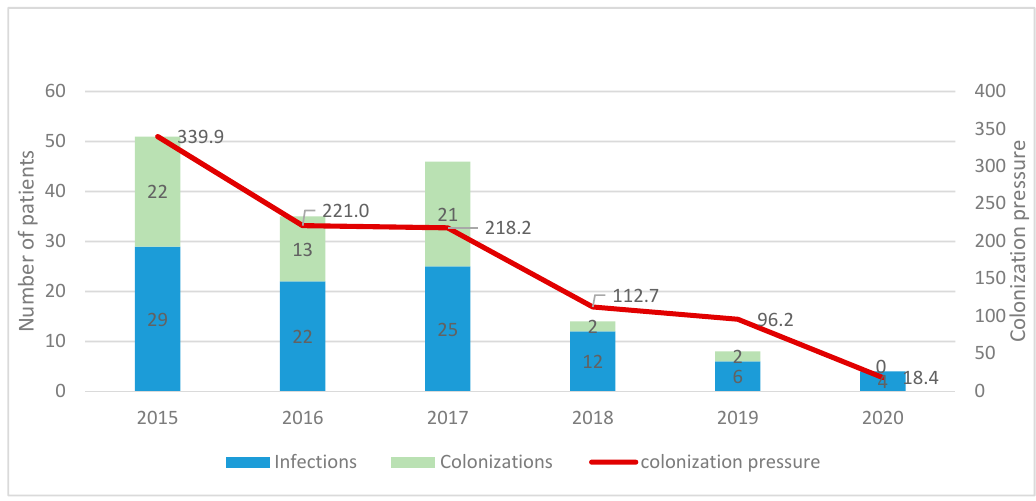
Figure 5. CRAb colonization pressure in ICU over a 7-year period by year.